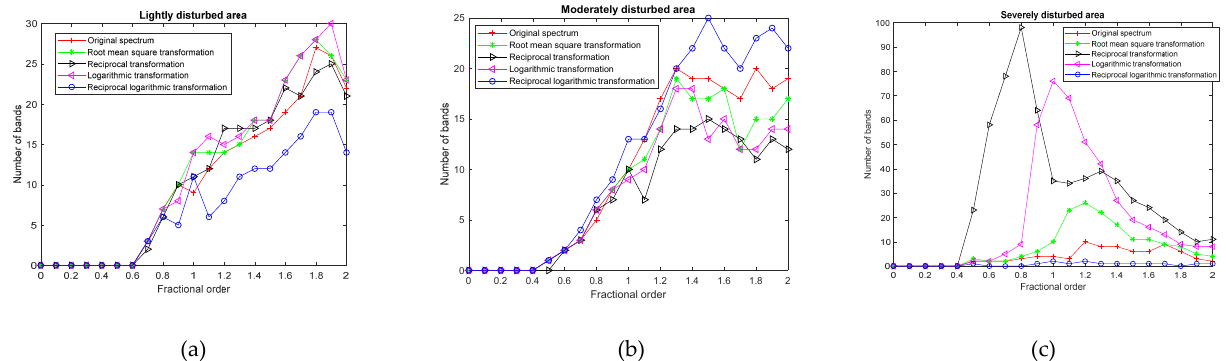
Figure 6. The number of bands where the correlation coefficient between each spectral transformation and Na + passed the 0.01 test: ( a ) Area A, ( b ) Area B, ( c ) Area C.